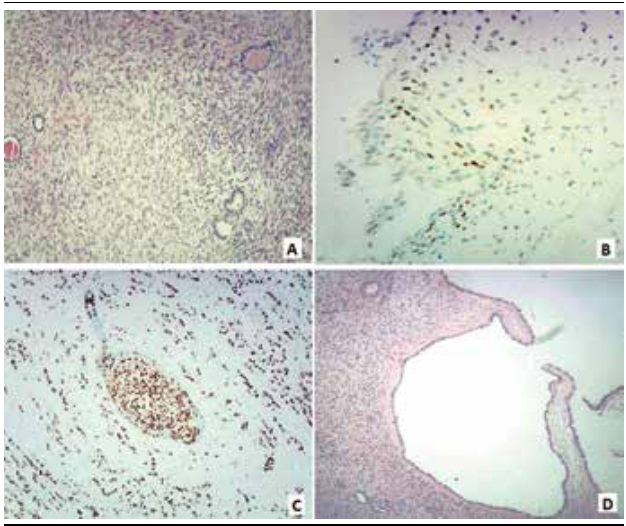
figuRE 3 − Mixed epithelial and stromal tumor A) a biphasic tumor composed by spindle cells and epithelial elements; B) positive immunoexpression for estrogen receptor in the stromal component, streptavidin-biotin, 400×; C) positive control for estrogen receptors in breast invasive ductal carcinoma, streptavidin- biotin, 200 × ; D) epithelial covering cystic formations, hematoxylin-eosin,